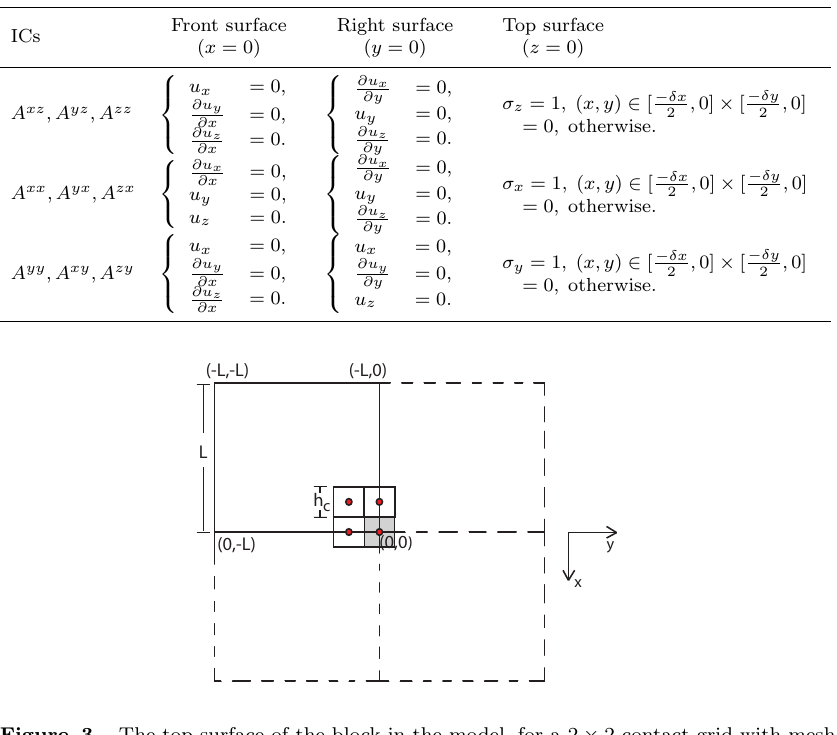
Table 1. Boundary conditions at the front surface ( x = 0), at the right surface ( y = 0) and at the top surface ( z = 0) for different ICs. On the other three surfaces the boundary condition is given by u = 0 .